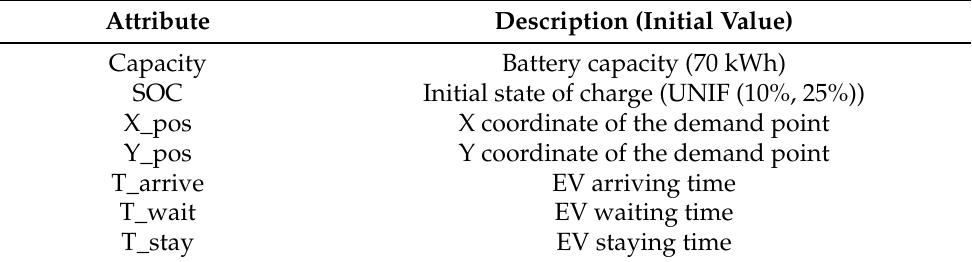
Table 2. EV attributes.